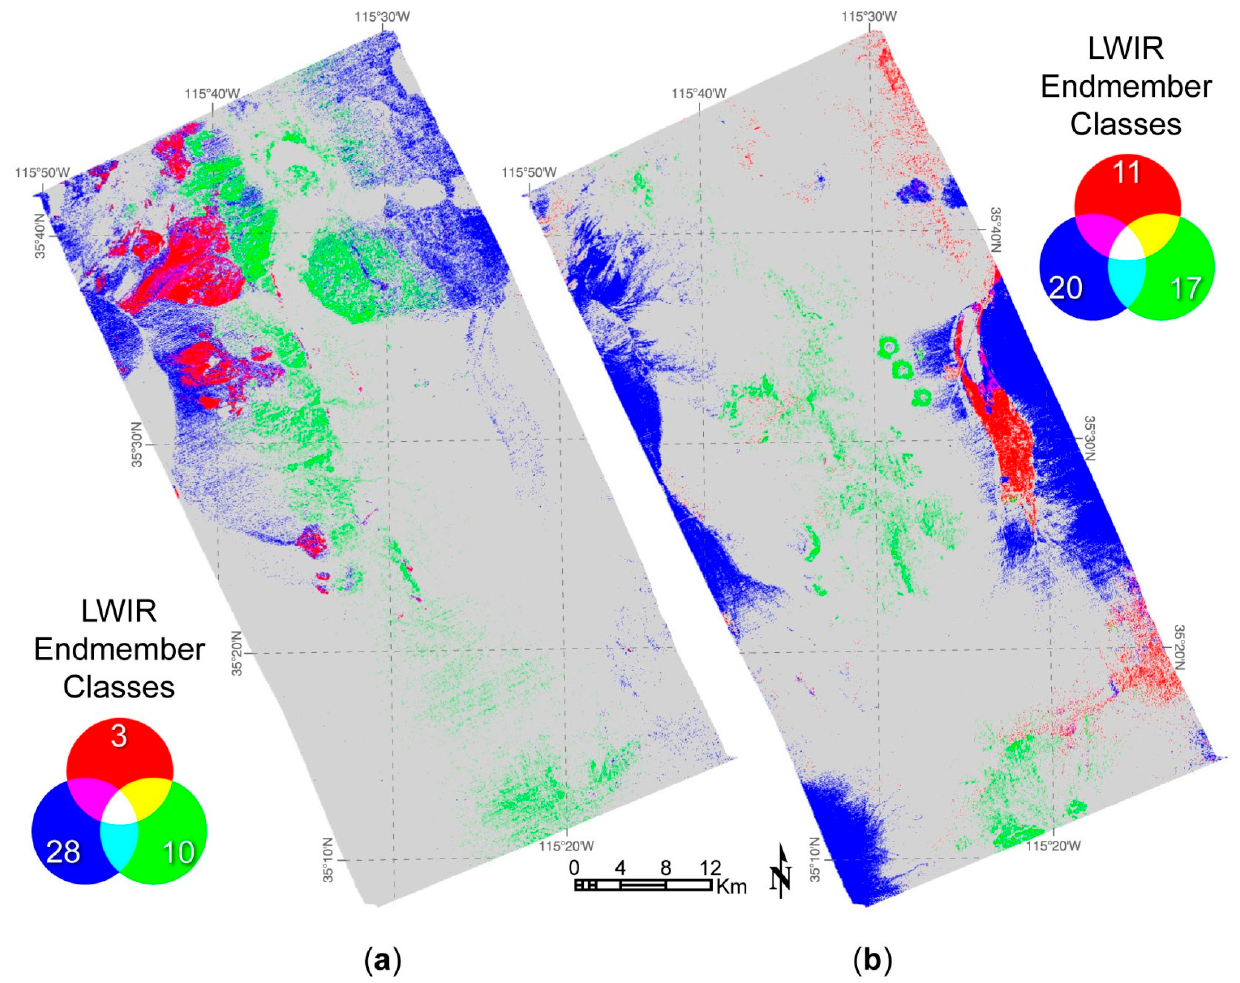
Figure 10. False color composite images of selected longwave infrared (LWIR) endmember classes: ( a ) 3/10/28 in red/green/blue; ( b ) 11/17/20 in red/green/blue. Pixels with approximate abundance values less than 40% for the selected endmembers are masked in gray.